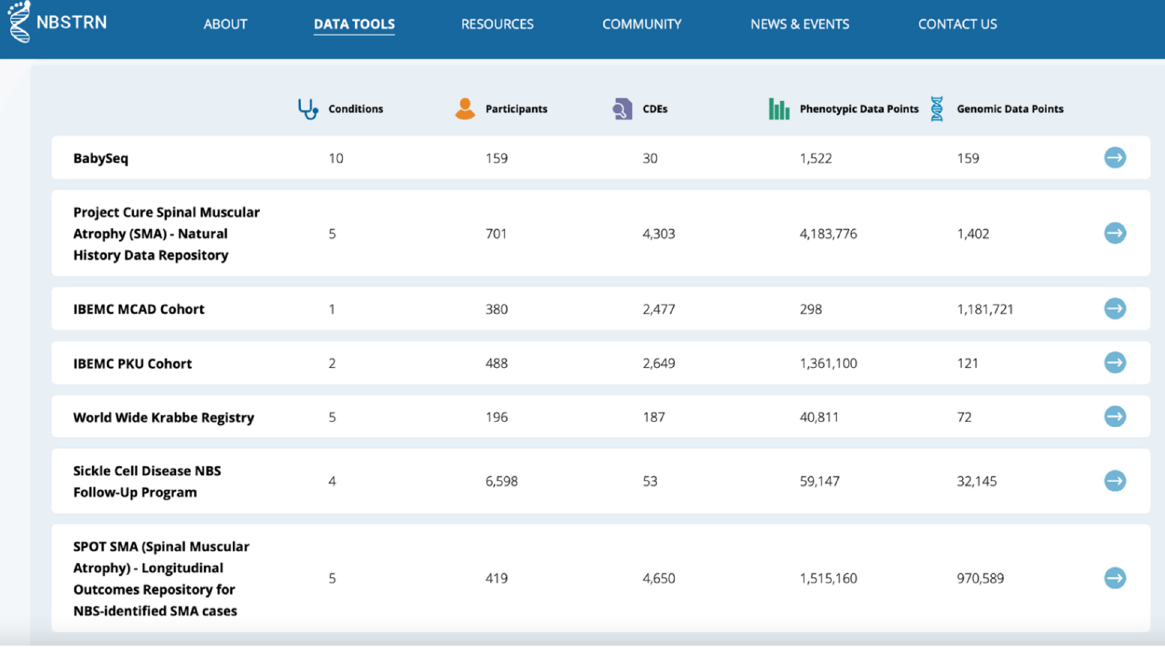
Figure 3. LPDR Projects Available for Secondary Use. Table 1. Summary of Projects in the NBSTRN